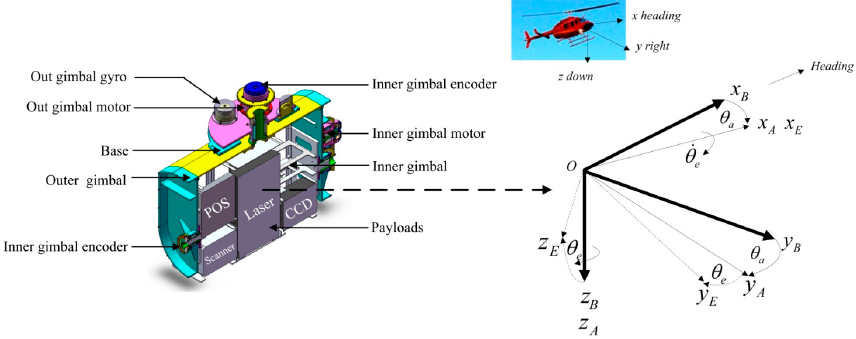
Figure 2. The structural diagram of a two-axis ISP with multi-sensors in an APLI system.